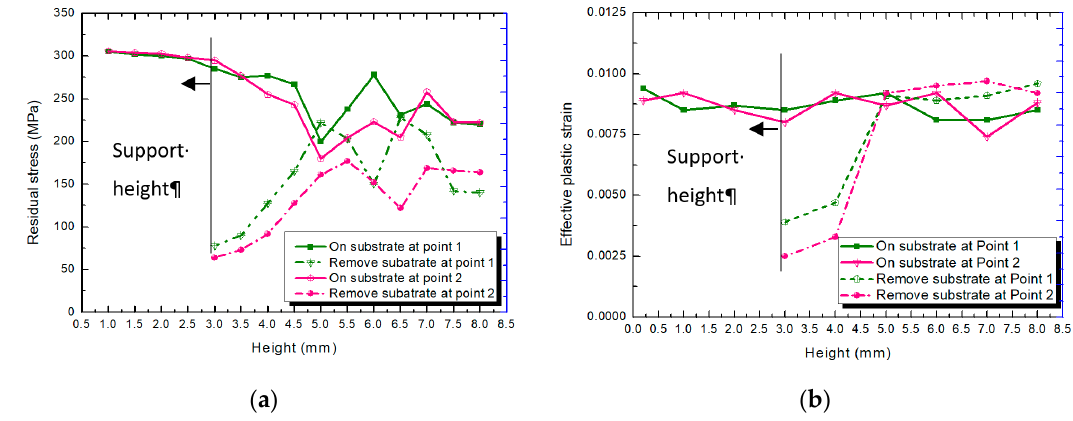
Figure 6. Development trend of thermal–residual stress before and after the removal of the substrate: ( a ) residual Stress; ( b ) residual strain.